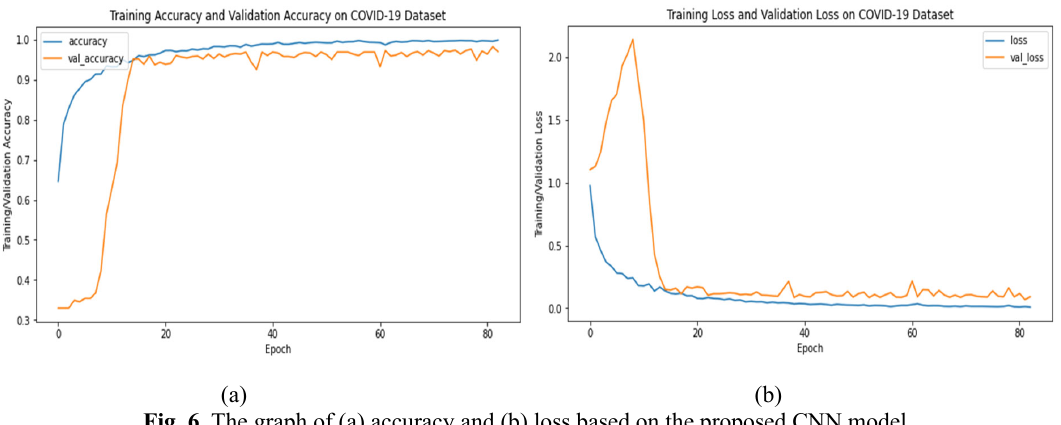
Fig. 6. The graph of (a) accuracy and (b) loss based on the proposed CNN